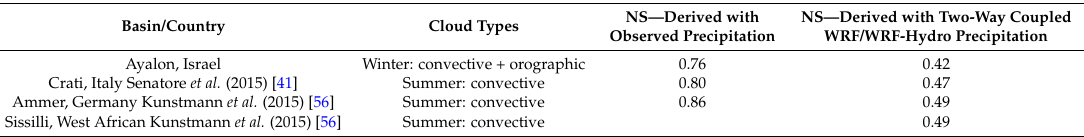
Table 4. Results for the Nash–Sutcliffe test for WRF-Hydro derived by observed precipitation and WRF-Hydro two way derived by simulated WRF